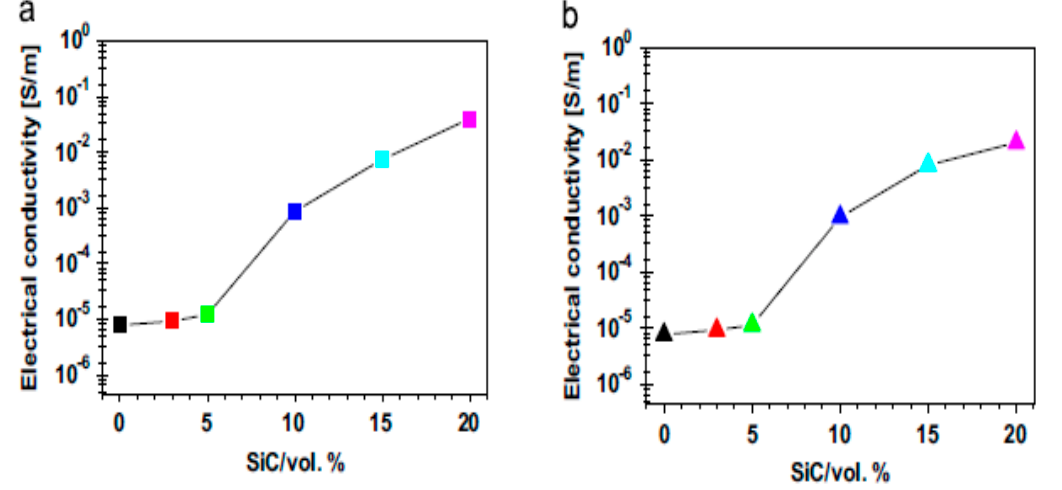
Table 5. Electrical conductivity of Al 2 O 3 –SiC nanocomposites.